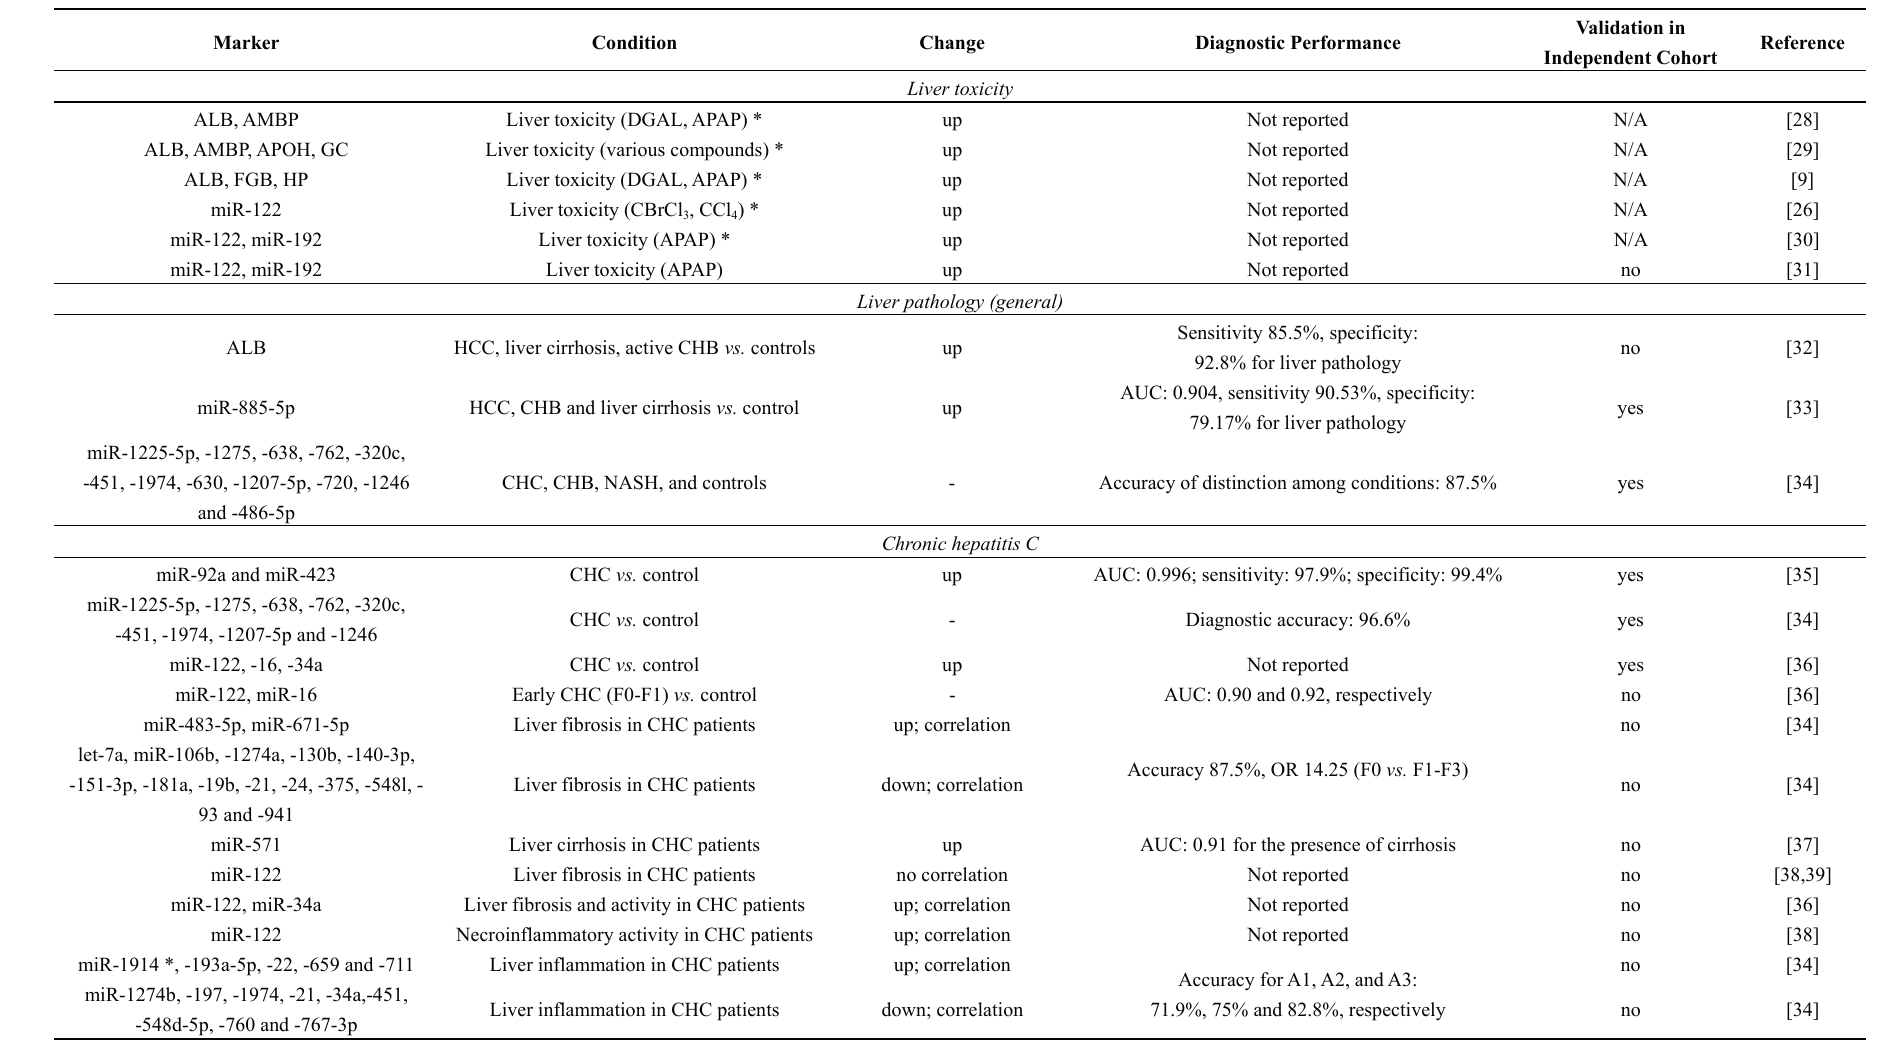
Table 1. Circulating RNA as biomarkers in liver